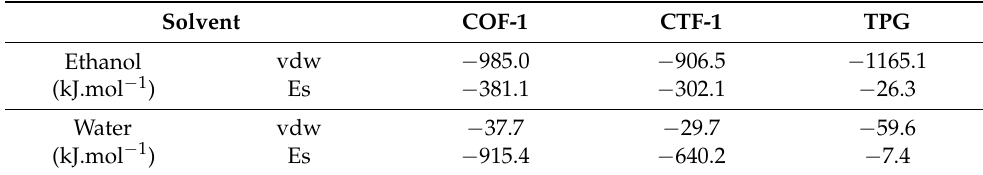
Table 3. Non-bonded interaction energies